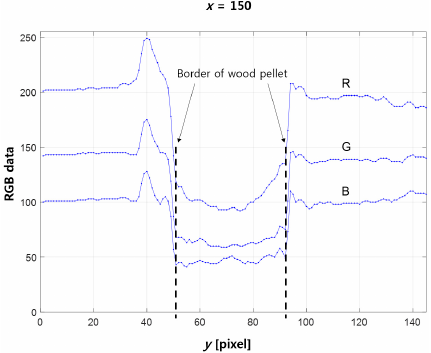
Figure 6. RGB data of image file of wood pellet in flame burning mode (Figure 5) along y pixel at x = 150.